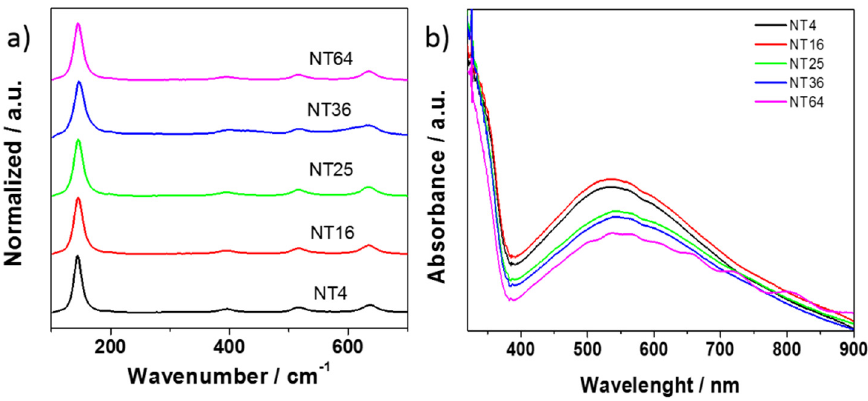
Figure 3. ( a ) Raman spectra and ( b ) the absorbance spectra recorded for a series of titania nanotube electrodes of different dimensions.